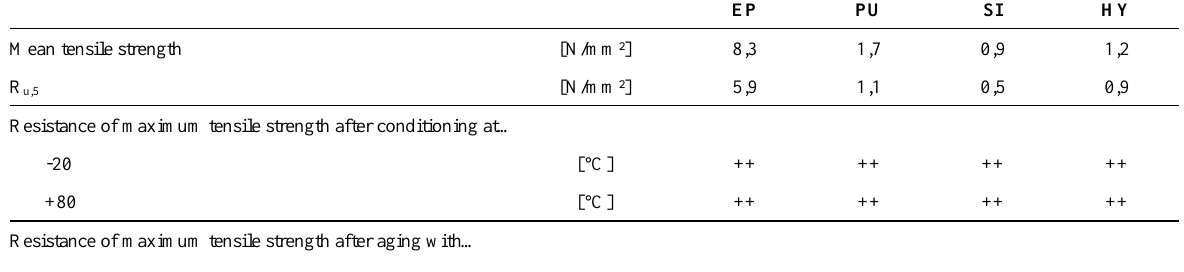
Table 3: Rating of structural adhesives for an application as load-bearing adhesives considering hydrothermal aging.